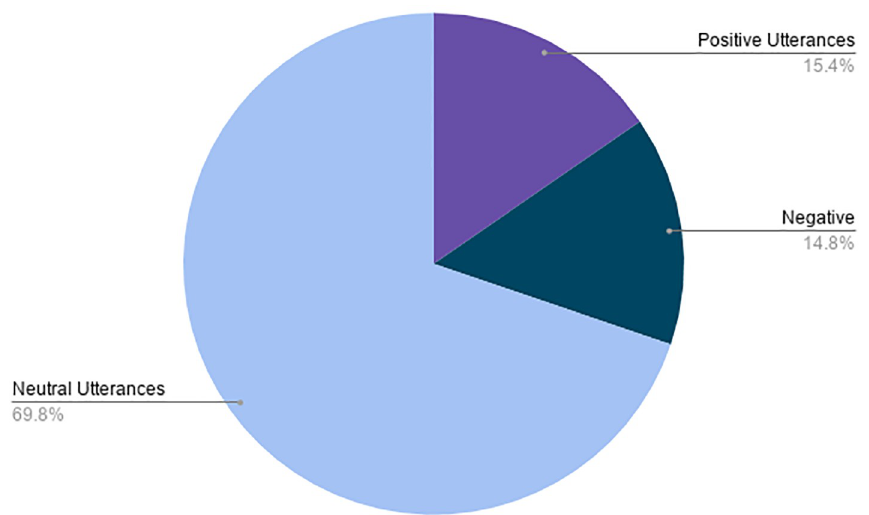
posed phone when he/she gets to know its cost. The Discrepancy module recognizes the neg- ative sentiment as a discrepancy point and triggers the goal manager depending on user action. The goal manager updates the previous goal by incorporating the user’s feedback ( cost < 500 ). The GDA Signal (discrepancy and updated goal) along with the current dia- logue state are passed to the policy tracker. Next, the VA shows a phone matching with the